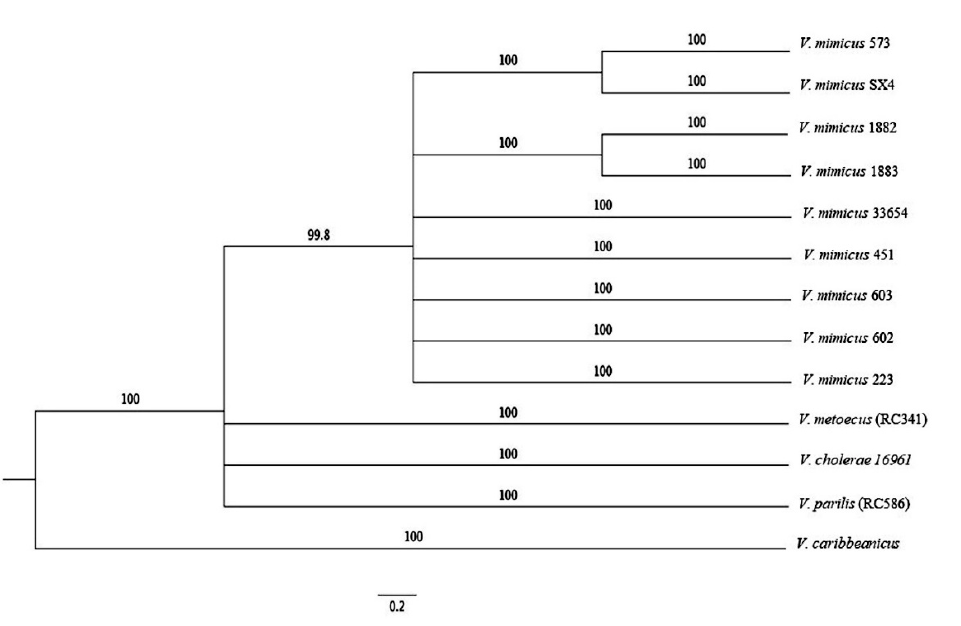
Figure 5. ML phylogenetic tree of eight housekeeping genes (ftsZ , gapA , gyrB , topA , rpoA , recA , mreB , and pyrH ) of the nine strains of V. mimicus , V. cholerae 16961, V. parilis ( RC586), V. metoecus (RC341), and V. caribbeanicus ATCC BAA-2122.